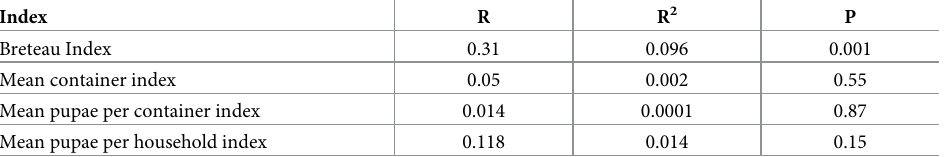
Table 3. Associations between vector indices and proportion of households with positive dengue serology at clus- ter level (150 clusters) from Pearson’s linear